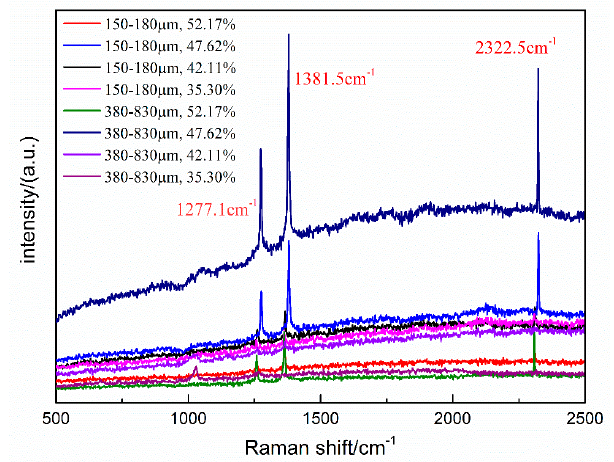
Figure 8. Raman spectra of hydrates formed in zeolite systems with different water contents at 271.2 K.